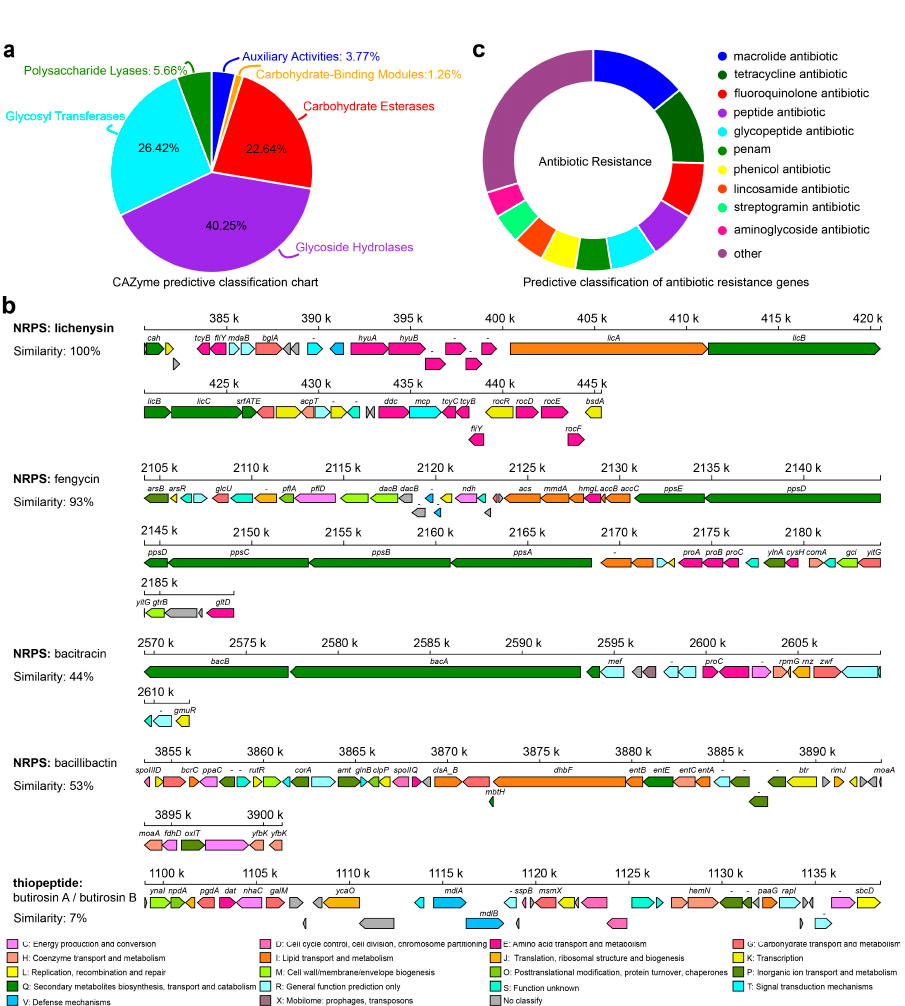
Figure 6. Metabolic system analysis of B. paralicheniformis RP01. ( a ) Carbohydrate-active enzyme prediction in RP01. ( b ) The secondary metabolite gene cluster prediction of RP01, and the colors of boxes based on the COG classification. ( c ) Drug resistance gene prediction in RP01